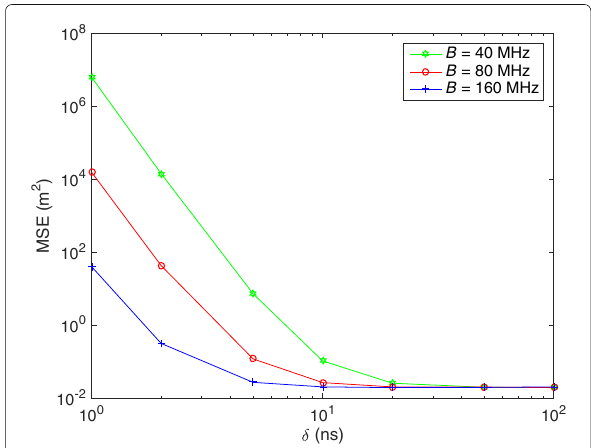
Fig. 8 Numerical result 6. MSE versus δ with B as a parameter, for M = 4, ρ = 0 dB, and N P =